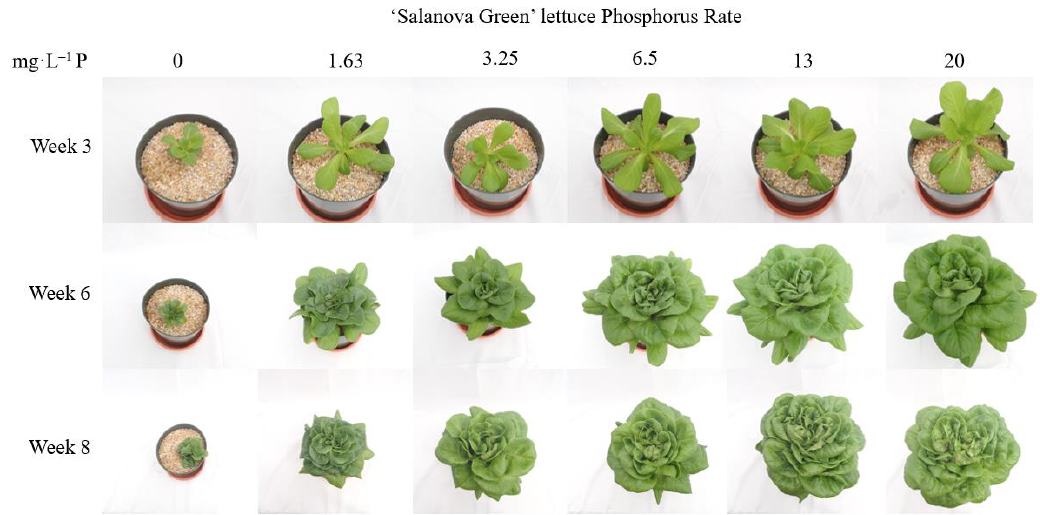
Figure 2. Visual impact of phosphorus (P) fertility rate on Lactuca sativa ‘Salanova Green’ at Weeks 3, 6, and 8. Table 3. Impact of phosphorus fertility rate on plant dry weight and phosphorus leaf tissue concen- tration on ‘Salanova Green’ lettuce. ‘Salanova Green’